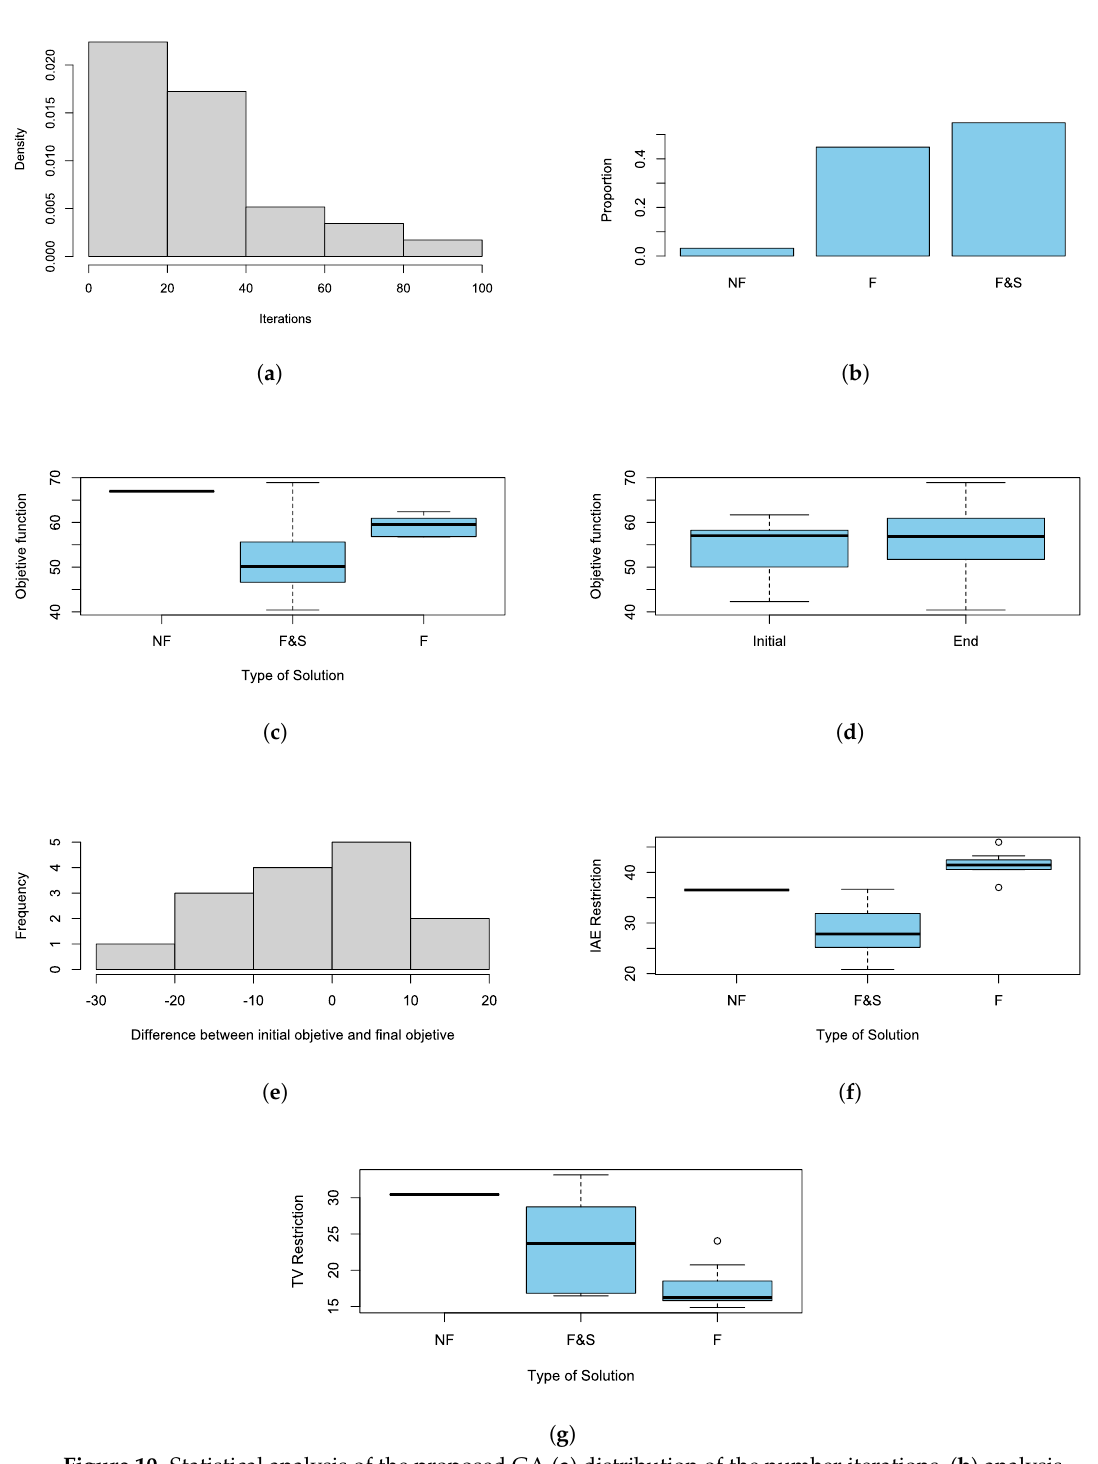
Figure 10. Statistical analysis of the proposed GA ( a ) distribution of the number iterations, ( b ) analysis of not feasible (NF), feasible (F) and feasible and suitable solution (F&S), ( c ) estimated standard deviation of the objective reached, ( d ) obtained values of the objective function, ( e ) change of the objective function, ( f ) change of the Integral Absolute Error (IAE) restriction, and ( g ) change of the TV